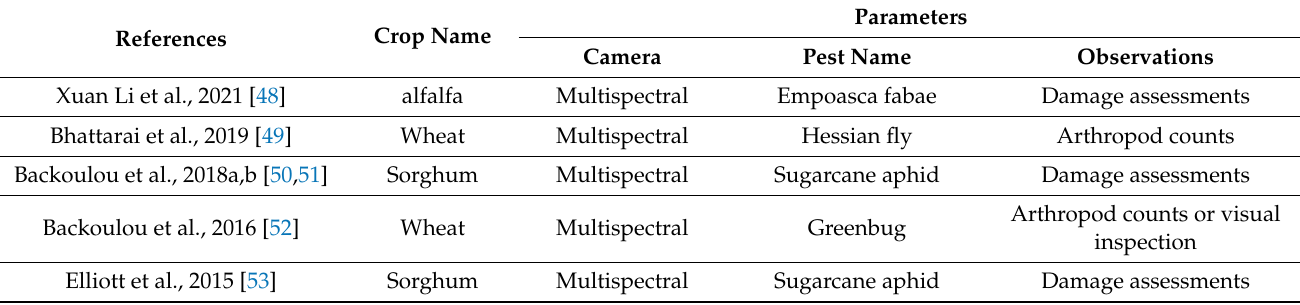
Table 4. Aerial (manned aircraft) based remote